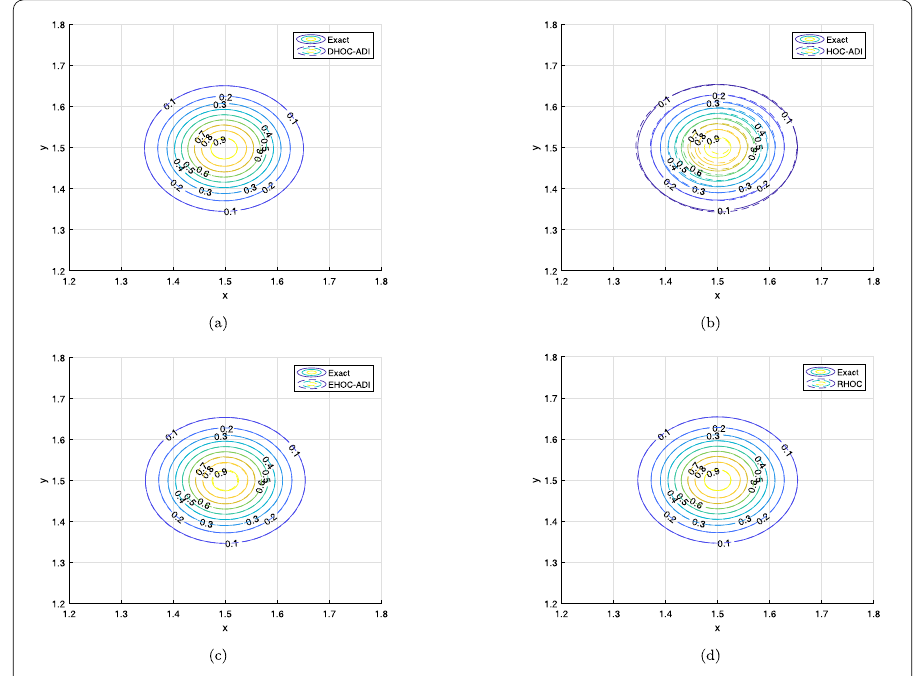
Figure 5 Contour lines of pulses in the sub-region 1.2 ≤ x , y ≤ 1.8 at final time t = 0.01 with Pe = 100 and τ = 2.5 × 10 –5 : ( a ) exact and present DHOD-ADI, ( b ) exact and HOC-ADI, ( c ) exact and EHOC-ADI, and ( d ) exact and RHOC-ADI. Dash-dot contour lines in ( a )–( d ) correspond to numerical